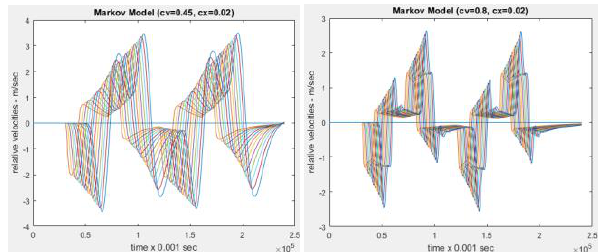
Fig. 20. The impact of the initial conditions on the relative velocity.